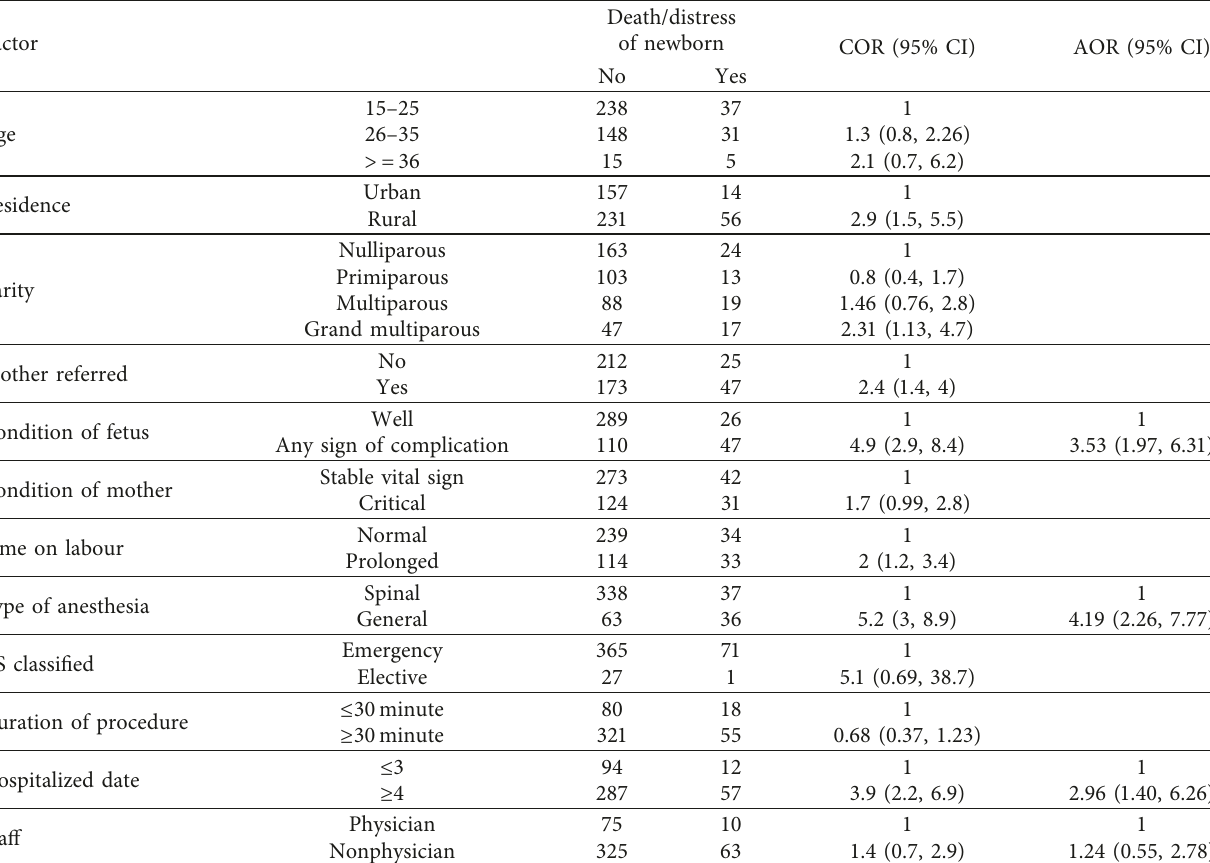
Table 2: Factors affecting newborn outcome of cesarean